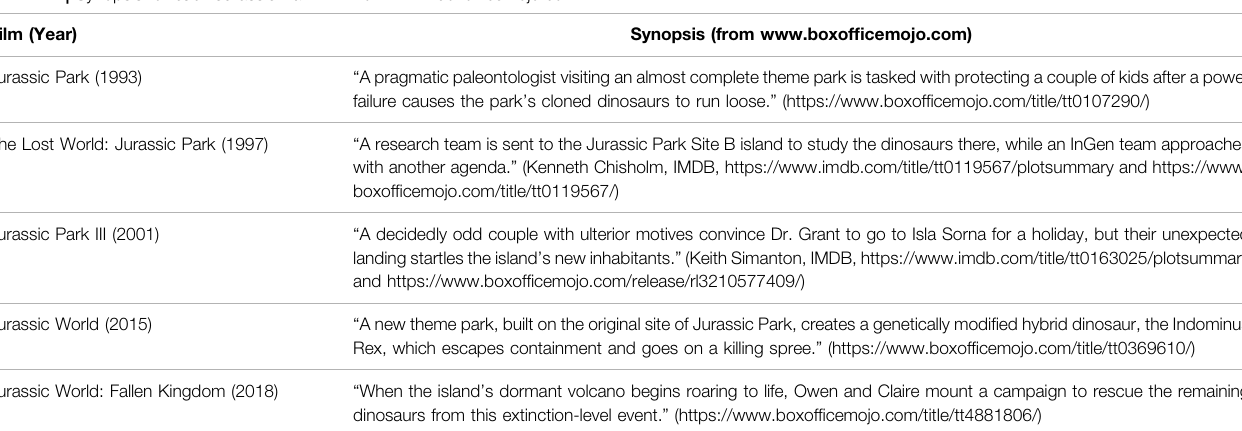
TABLE 2 | Synopsis for each Jurassic Park fi lm from www.boxof fi cemojo.com.